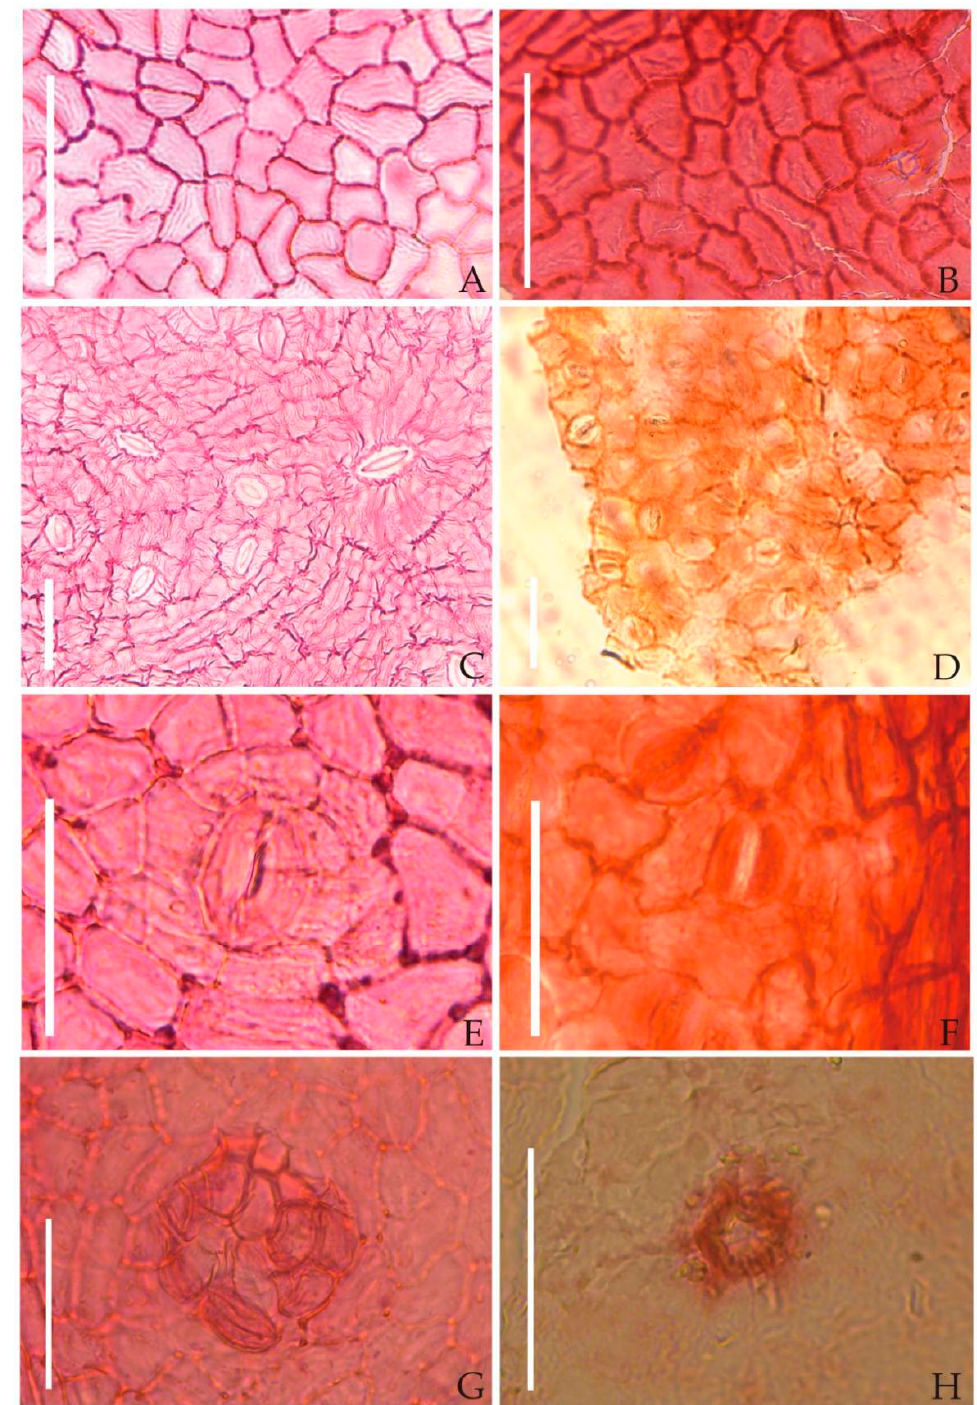
Figure 7. Epidermal characteristics of the extant and fossil Choerospondias (( B , D , F , H ), GT-14-629). ( A ): Epidermal cells in the upper epidermis of the extant Choerospondias . ( B ): Epidermal cells in the upper epidermis of fossil Choerospondias . ( C ): Lower epidermal of extant Choerospondias . ( D ): Lower epidermal of fossil Choerospondias . ( E ): Lower epidermal stomatal apparatus of the extant Choerospondias . ( F ): Lower epidermal stomatal apparatus of fossil Choerospondias. ( G ): Extant Choerospondias trichome base. ( H ): Fossil Choerospondias trichome base. ( A , B ): Scale bar = 0.1 mm; ( C – H ): scale bar = 0.05 mm.